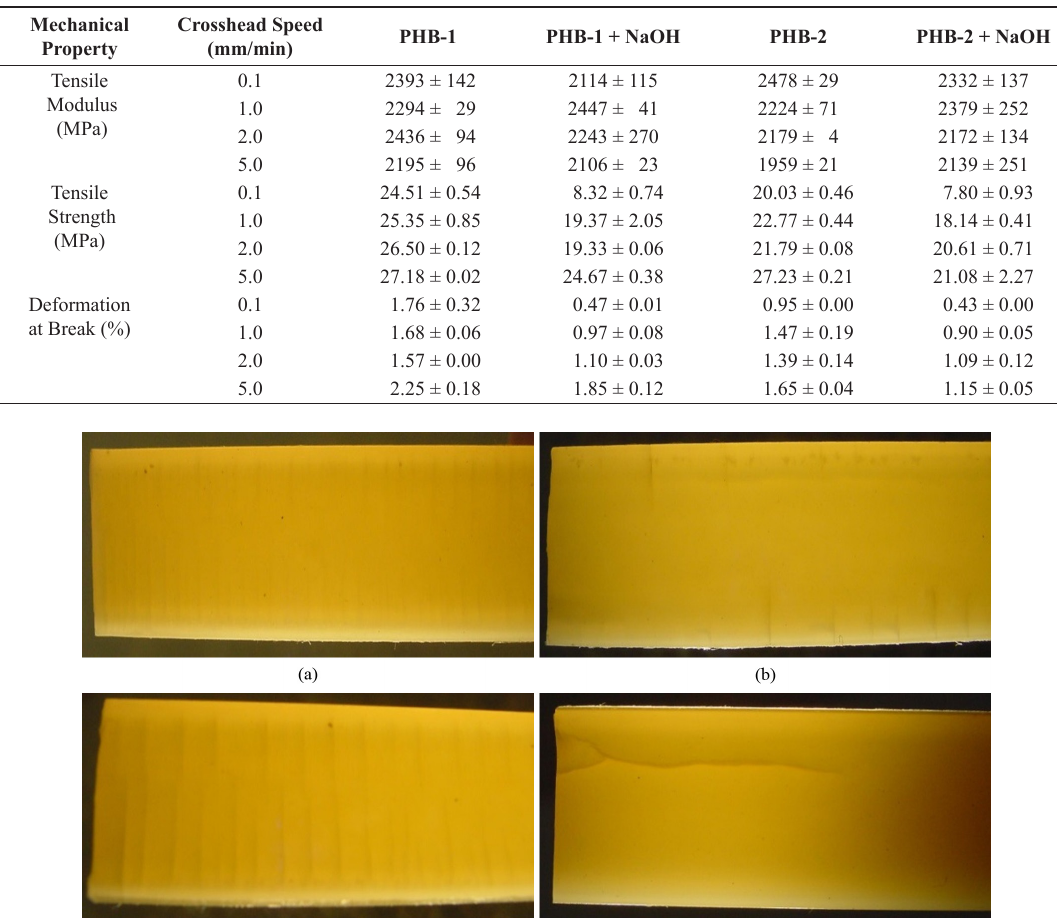
Table 2. Mechanical properties of PHB unexposed and exposed to NaOH 3M.